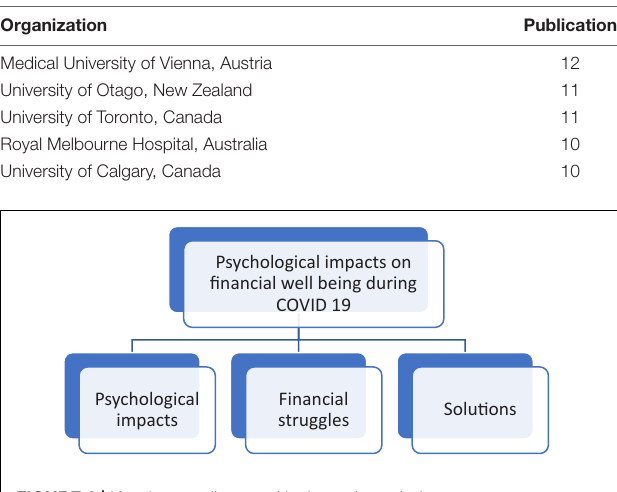
FIGURE 8 | Key themes discussed in thematic